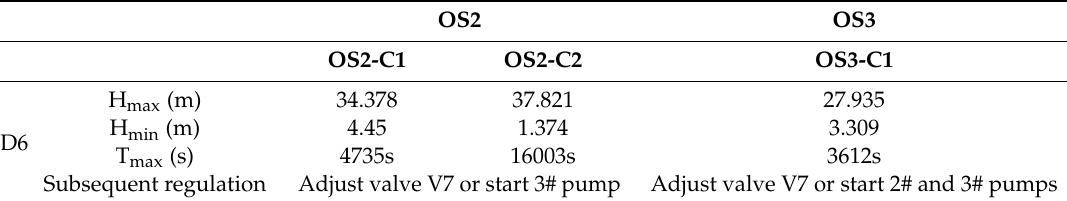
Table 7. The transient processes in three operating scenarios under D6.